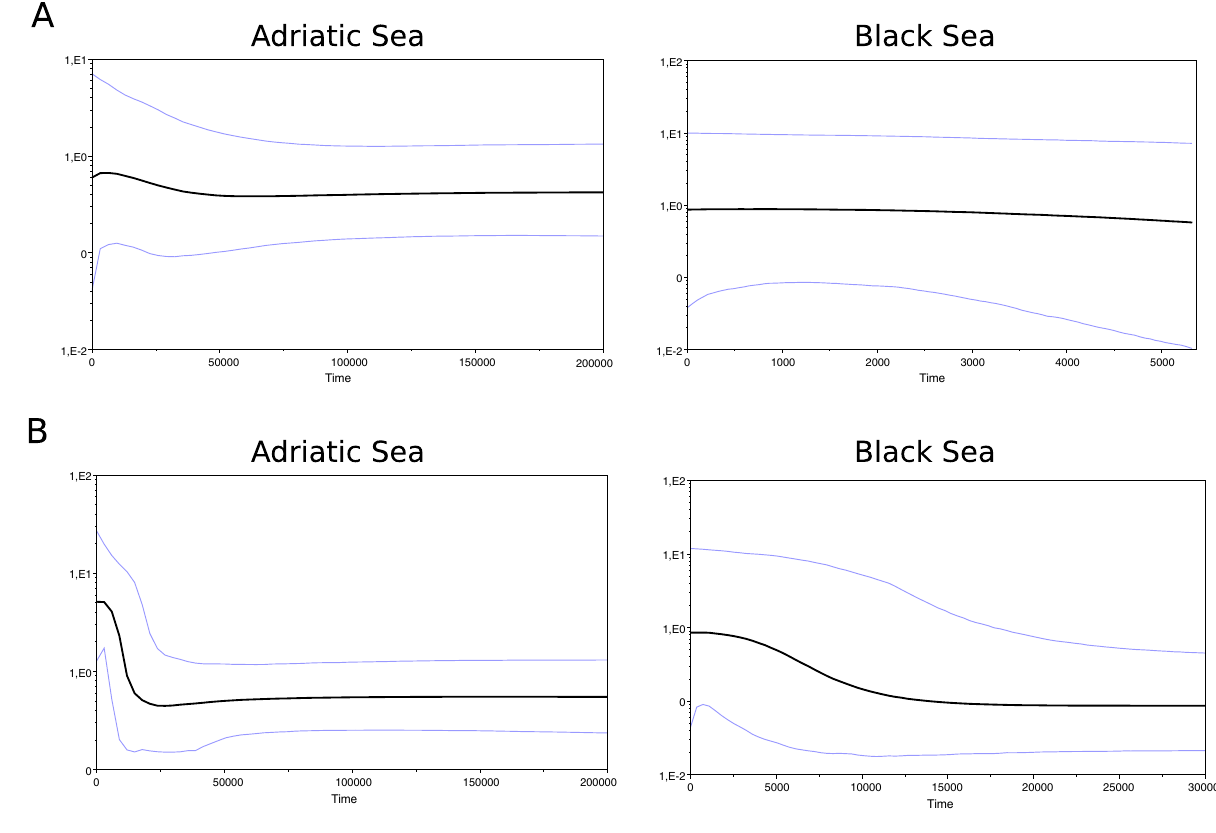
Figure 3. Bayesian Skyline Plots of Tritia neritea specimens from the Adriatic Sea and the Black Sea reconstructed from ( A ) sequences from this study only and ( B ) together with sequences already published. The X-axis indicates the time in years; the Y-axis indicates the female effective population size (NeT, with T = generation time). The black line is the median estimate of the estimated effective population size. The two blue lines are the upper and the lower estimates of 95% interval.